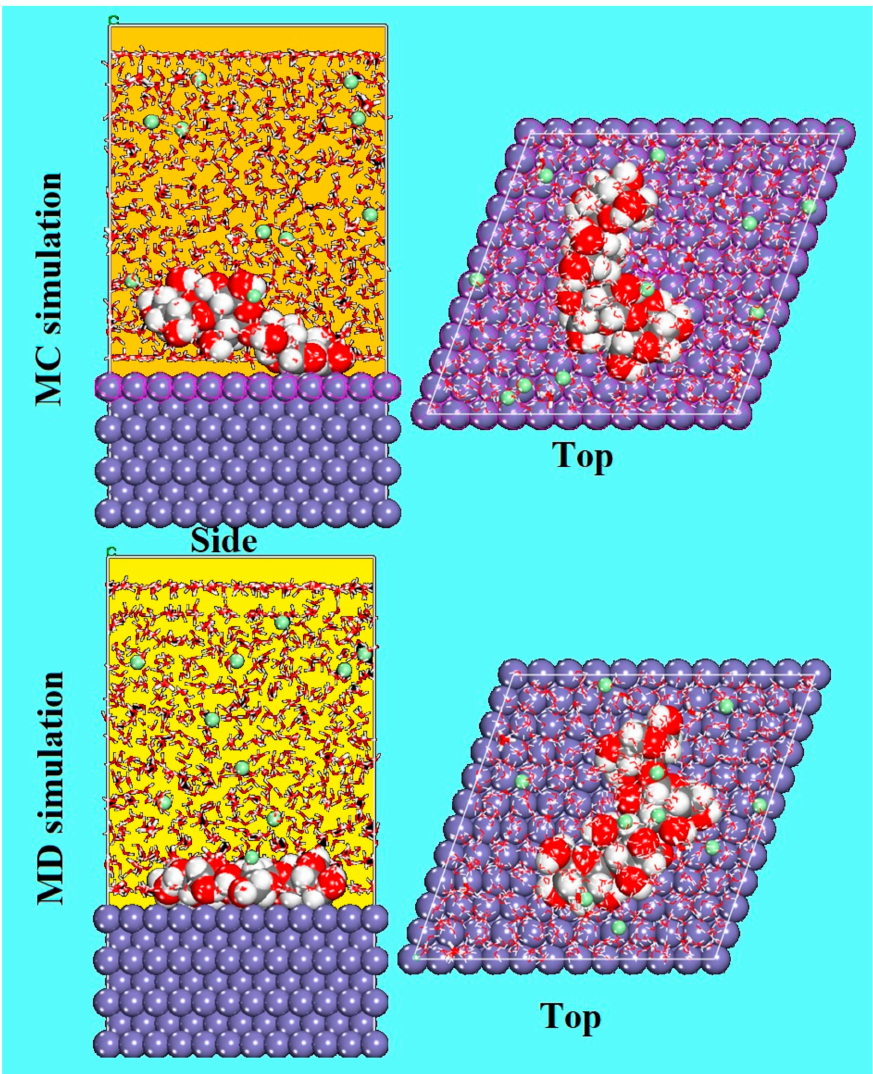
Figure 11. MC and MD simulations results from adsorption configurations and positions of the biopolymer CHA molecule present in the leaves and stems of Artemisia herba-alba